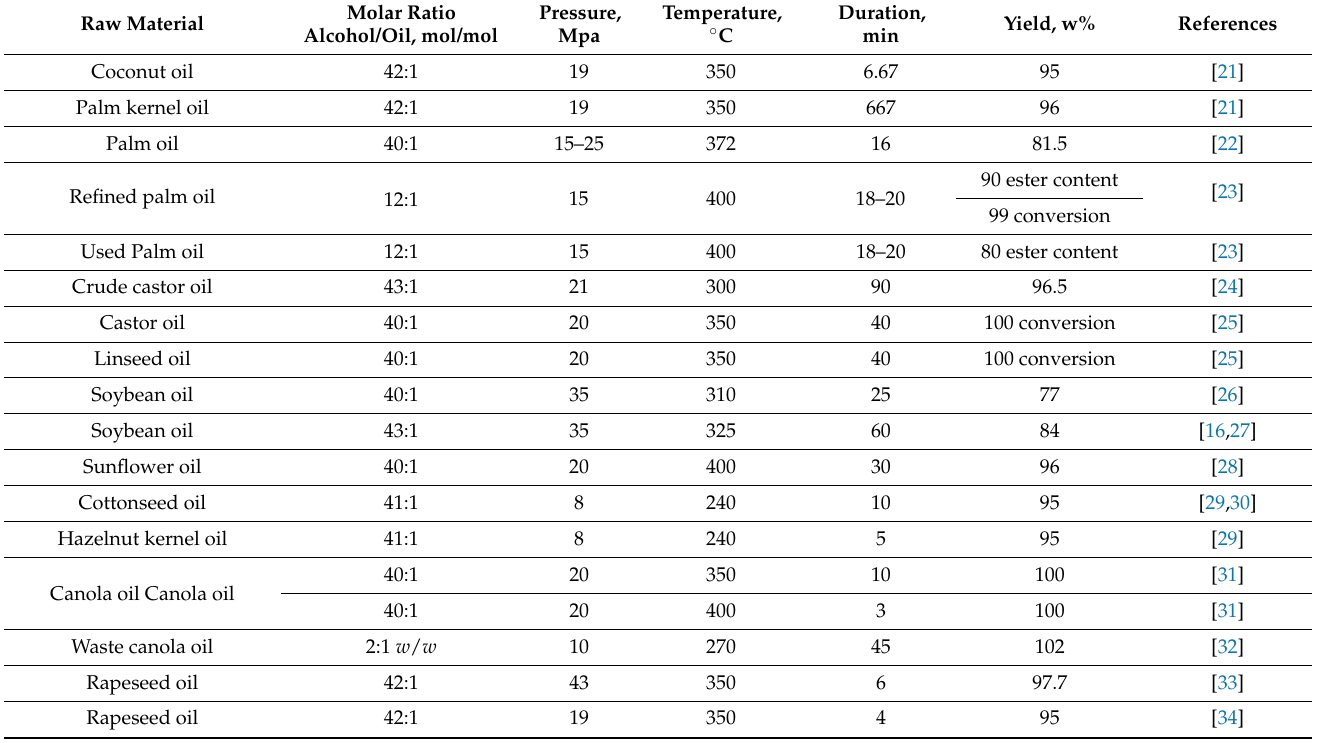
Table 1. Summary of reported experiment data for noncatalytic biodiesel production using supercritical methanol. Raw